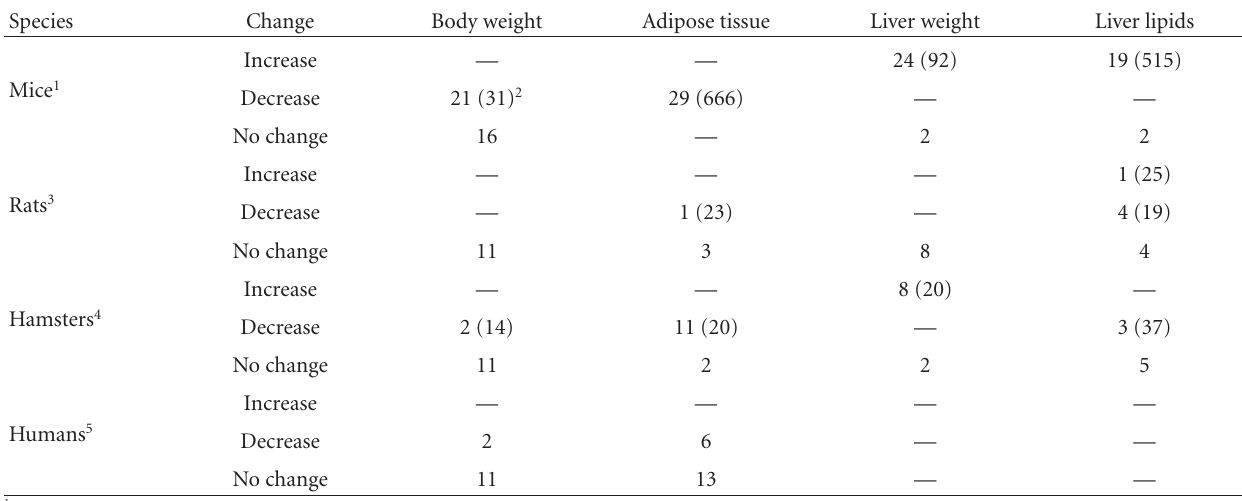
1 Studies used: [22, 25, 27–48]. 2 Number of observations (mean percent change). 3 Studies used: [49–53].